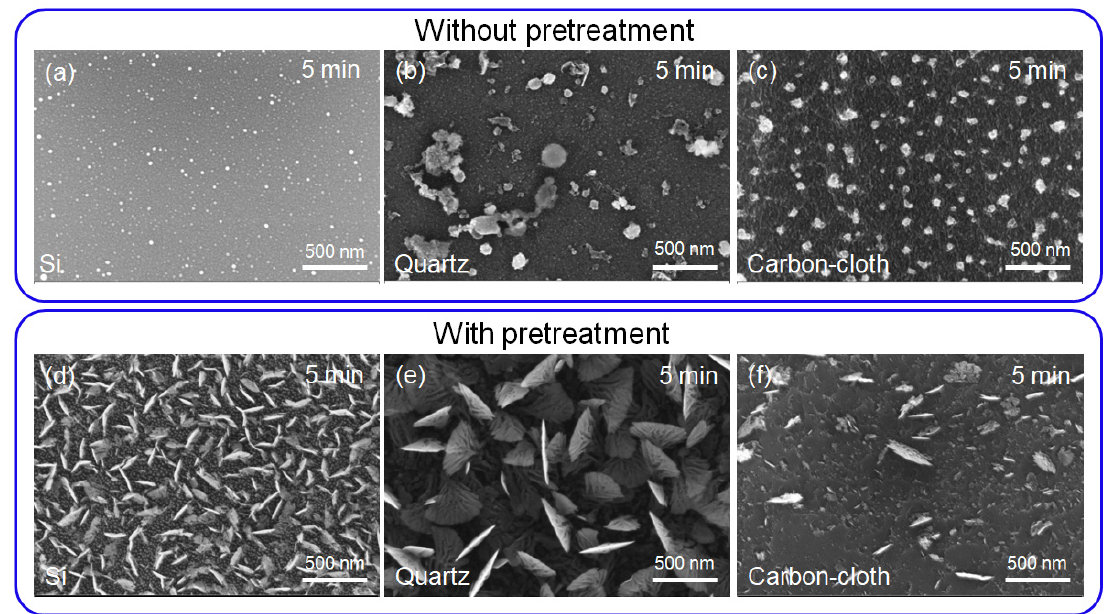
Figure 2. The surface energy of substrates’ influence on VFLG growth. ( a – c ) represent a VFLG growth time of 5 min on different substrates without pretreatment, where ( a ) is Si, ( b ) is quartz and ( c ) is flexible carbon-cloth. ( d – f ) show a VFLG growth time of 5 min on different substrates with pretreatment, where ( d ) is Si, ( e ) is quartz and ( f ) is flexible carbon-cloth. The different catalyses of substrates also led to different nucleation rates. Stain-